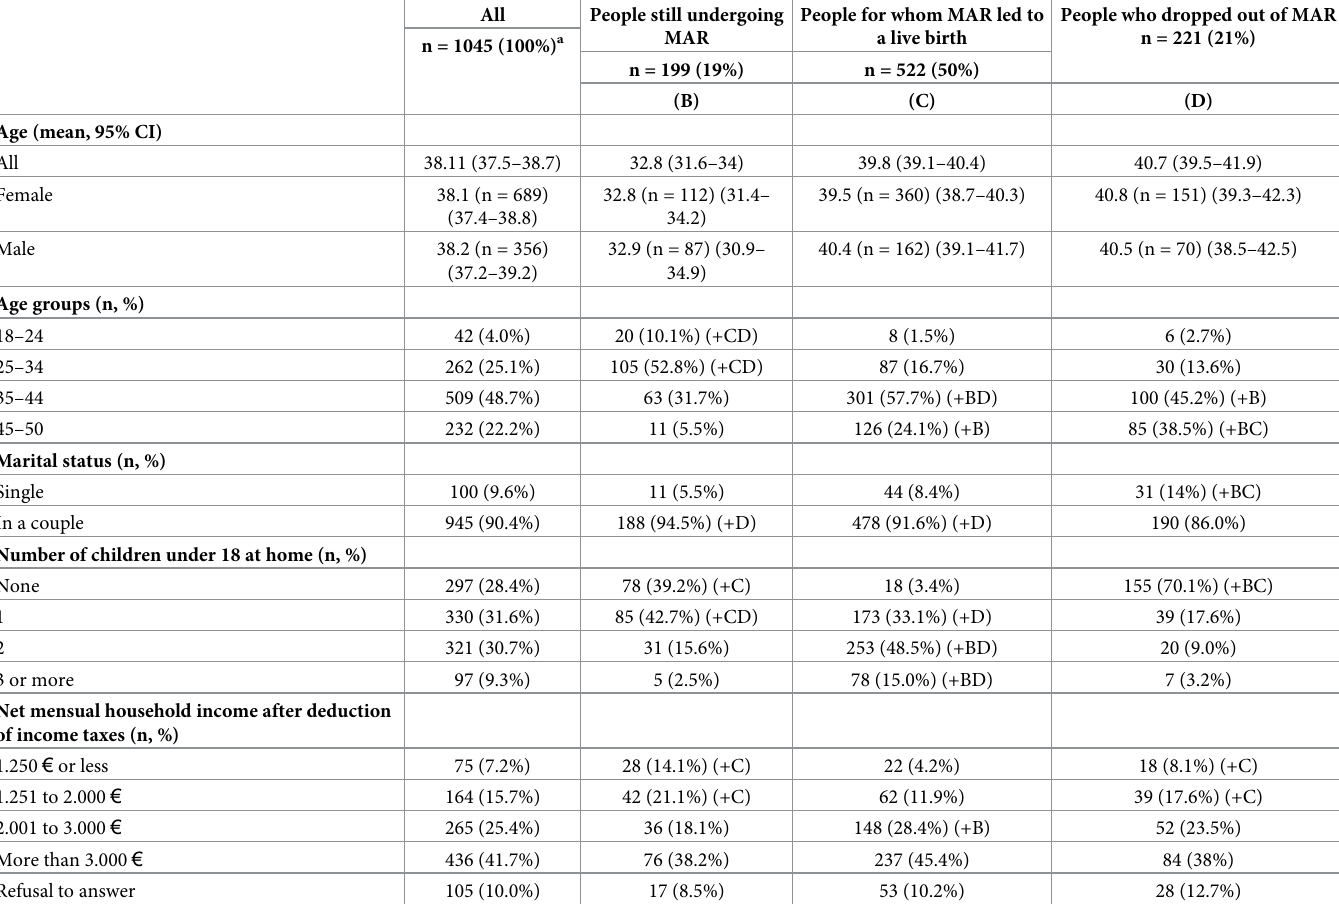
Table 1. MAR burden: A French national survey. Characteristics of the whole population of respondents (n = 1045) and of the three main subgroups of the survey popu- lation (n =